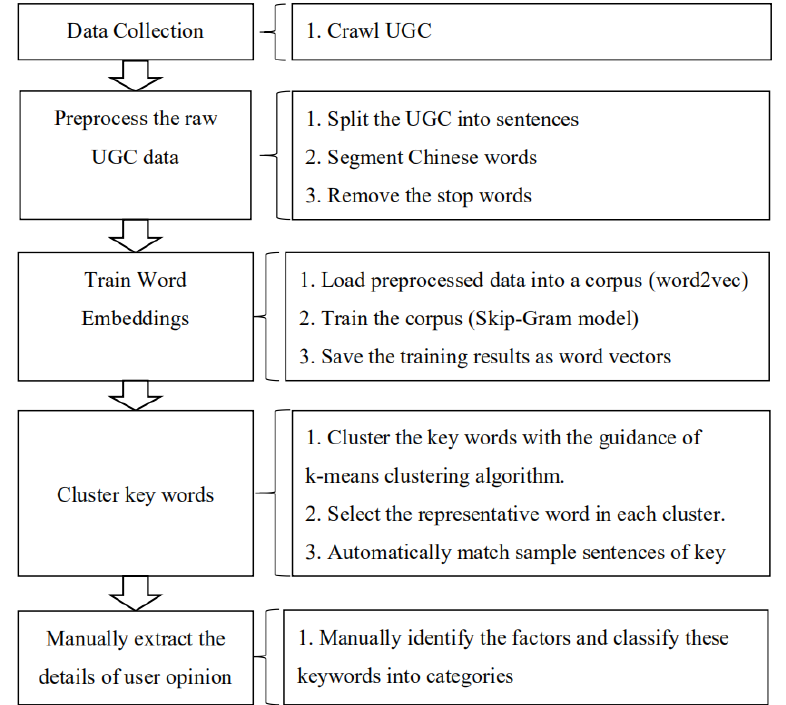
Figure 3. The methodological framework.